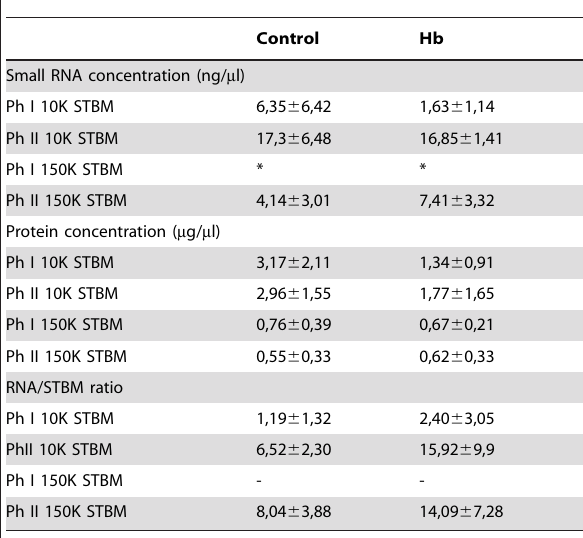
Table 1. RNA and protein concentrations, as well as RNA/ STBM